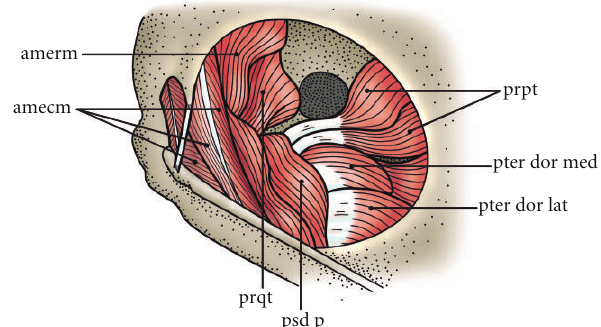
Figure 9: An oblique deep view of the jaw muscles of Picus mentalis. amecm: adductor mandibulae externus caudalis medialis; amerm: adductor mandibulae externus rostralis medialis; prpt: protractor pterygoidei; prqt: protractor quadrati; psd p: pseudotemporalis profundus; pter dor lat: pterygoideus dorsalis lateralis; pter dor med: pterygoideus dorsalis medialis.